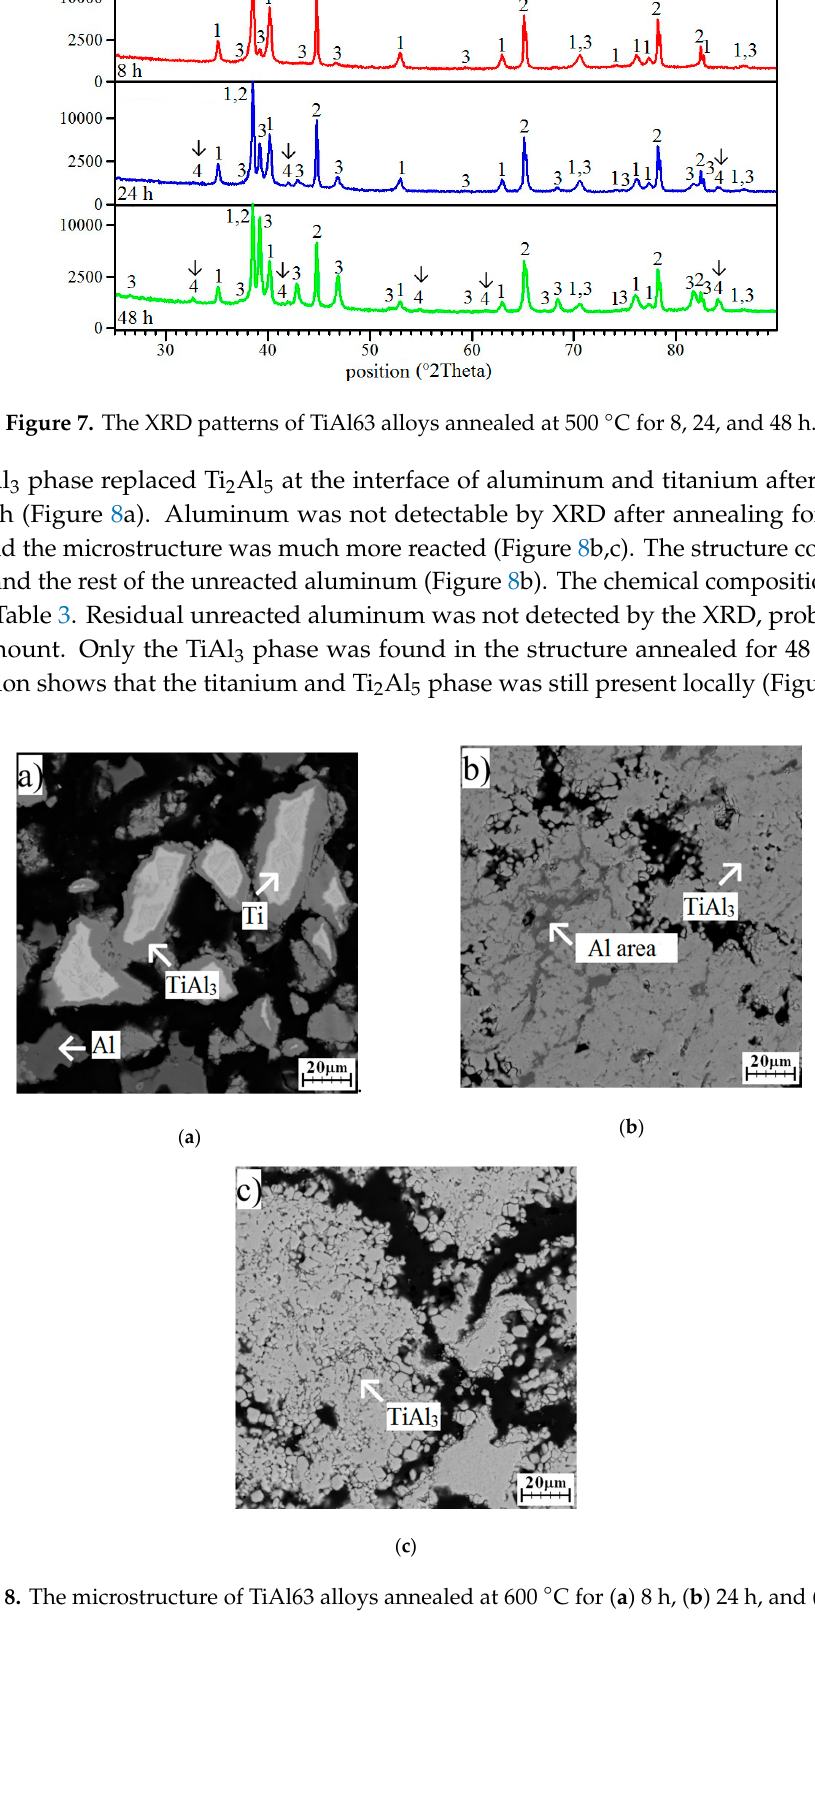
Figure 9. The XRD patterns of TiAl63 alloys annealed at 600 °C for 8, 24, and 48 h.